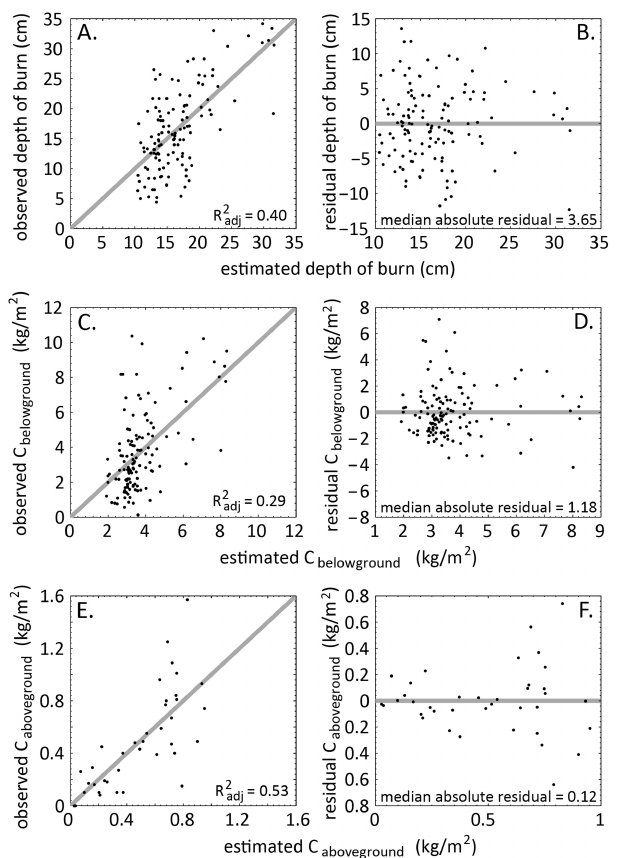
Figure 3. Scatter plots between the observed and estimated (a) depth of burn, (c) belowground and (e) aboveground carbon con- sumption from the multiplicative nonlinear model, and correspond- ing regression residuals ( b , d and f ). The gray line represents the 1 : 1 line in the left panels, and the y = 0 line in the right panels. All models were significant at p <